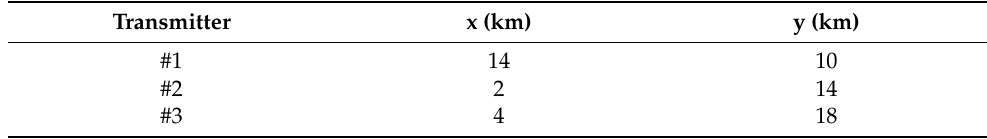
Table 3. Initial transmitting antennas positions.